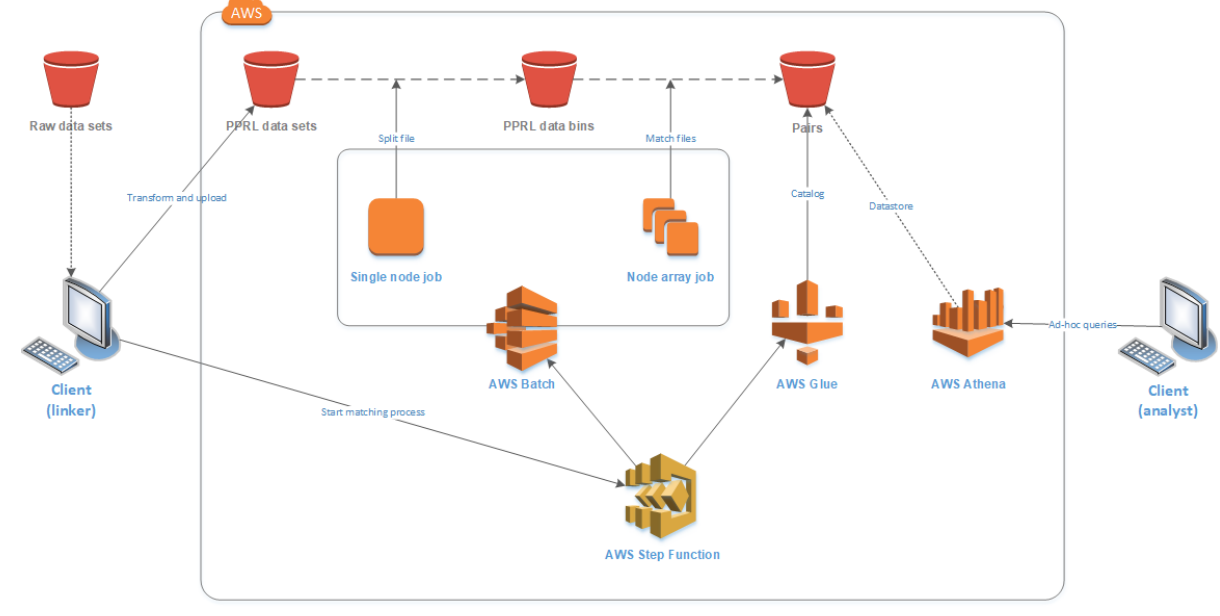
Figure 5. Prototype on Amazon Web Services. AWS: Amazon Web Services; PPRL: privacy-preserved record